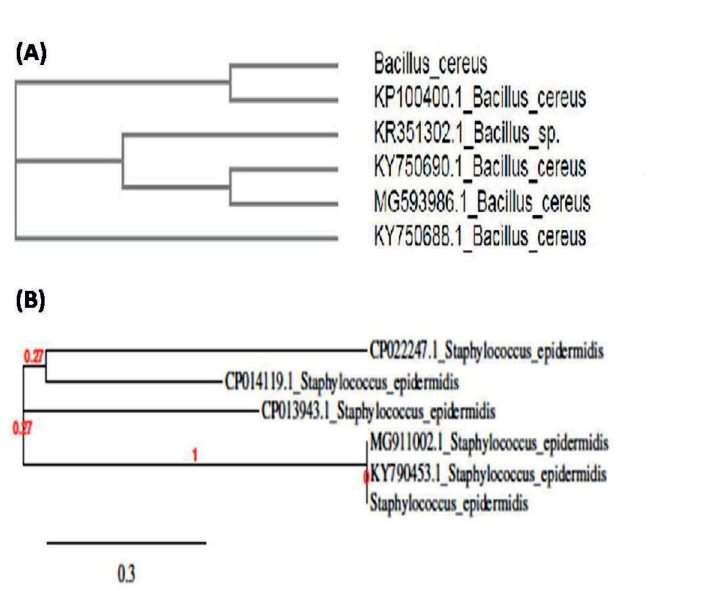
B, from the results of 16s rDNA sequencing and phylogenetic analysis SP Fig. 4. (A) Phylogenetic analysis of SP 1 was identified as Bacillus cereus ; (B) Phylogenetic analysis of B analysis SP B was identified as Staphylococcus 1